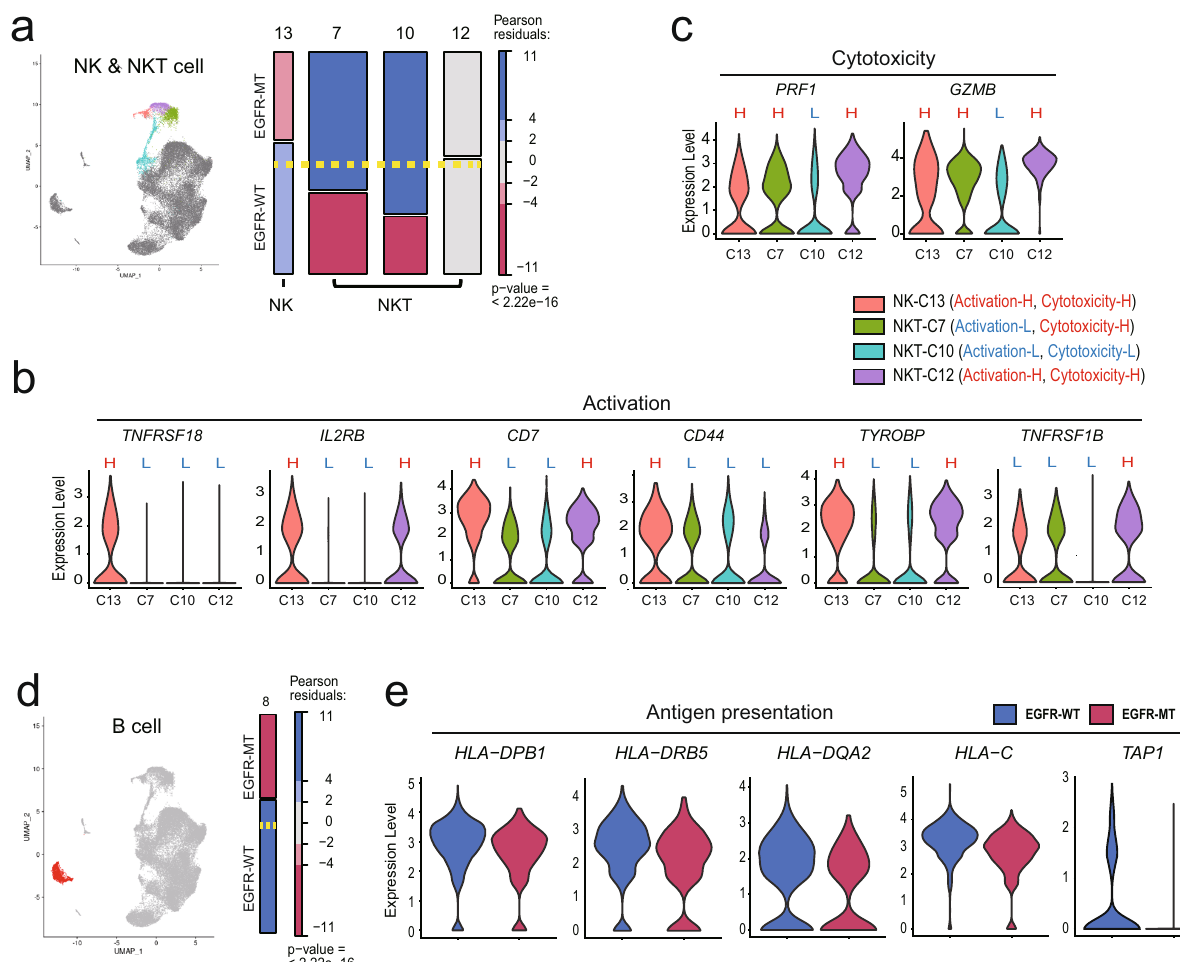
Fig. 2 Characterization of subsets for NK, NKT, and B cells based on marker gene expression. a UMAP and mosaic plots for NK and NKT cells. The p -value shown in the mosaic plot was obtained from a one-sided Chi-square test. b , c Violin plots for the expression of genes involved in activation ( b ) and cytotoxicity ( c ) of NK or NKT lymphocytes across subsets (H, high expression level; L, low expression level). Each subset was characterized based on the expression levels of genes involved in activation and cytotoxicity. For example, NKT-C7 was characterized by low activation and high cytotoxicity. d UMAP and mosaic plots for B cells. e Violin plots for the expression of genes involved in antigen presentation and processing in B cells of EGFR-WT or EGFR- MT EGFR-WT and EGFR-MT for each subset (group-DEG) (Supplementary Data 3).